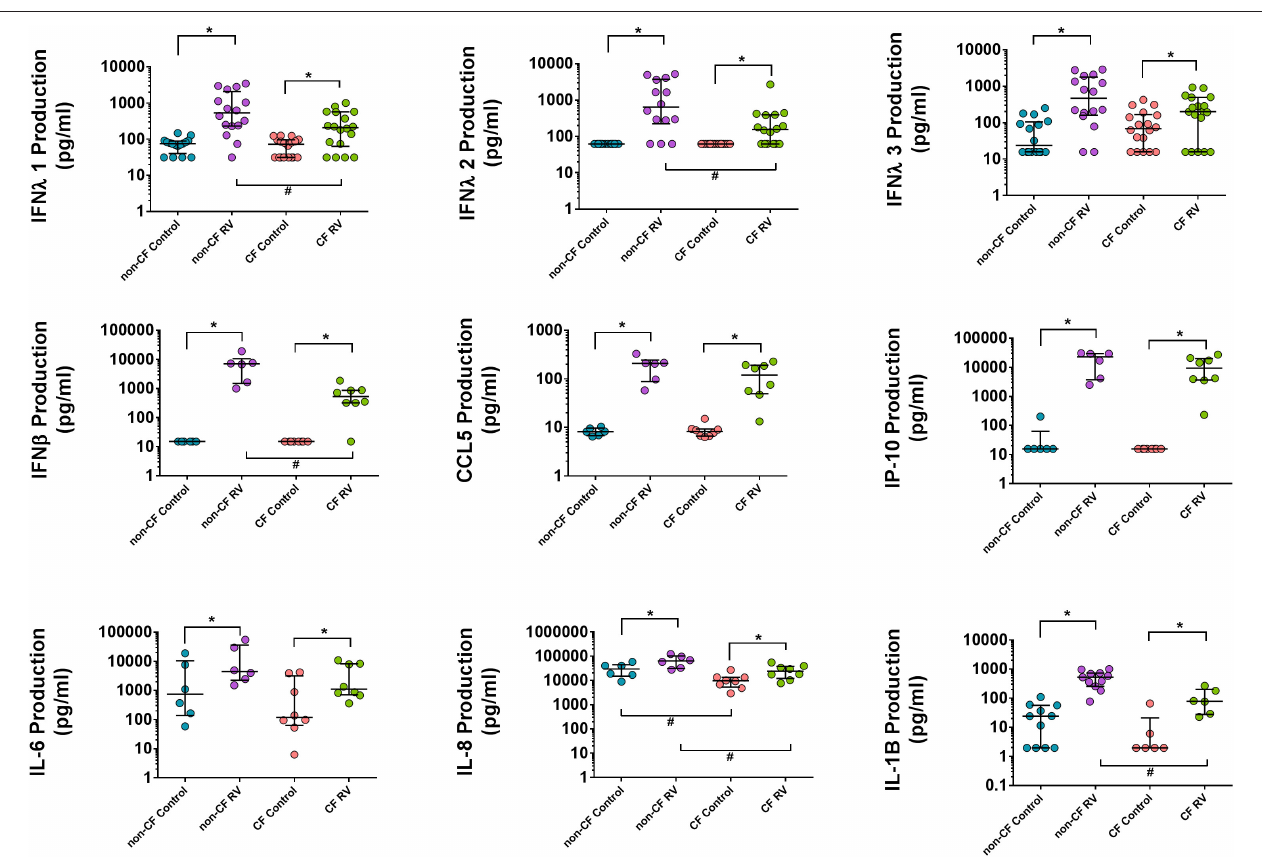
FIGURE 5 | Cytokine production in the supernatant AEC of non-CF individuals and children with CF following RV infection. Cytokine release was measured in cell culture supernatants using commercial ELISA kits and an in-house time-resolved fluorometry detection system. Type 1 and III interferons (IFN- β , IFN- λ 1, and IFN- λ 2) were significantly higher in non-CF AEC post-RV infection compared to CF AEC. Inflammatory cytokines IL-6, IL-8, and IL-1B were significantly increased in both CF and non-CF RV-infected samples with significantly higher IL-8 and IL-1B levels produced by non-CF RV-infected samples compared to CF RV-infected samples. RANTES (CCL5) and IP-10 were significantly elevated in CF and non-CF RV-infected samples but not significant between phenotype. Note: n 9–11 for non-CF and = 6–12 for CF. The data were represented as median IQR, symbols show statistical significance in RV-infected samples relative to paired non-infected control ± samples; * p < 0.05, determined using Wilcoxon test. Statistically significant for comparison between CF and non-CF non-infected samples determined using unpaired t -test or Mann–Whitney depending on Gaussian distribution, # p <